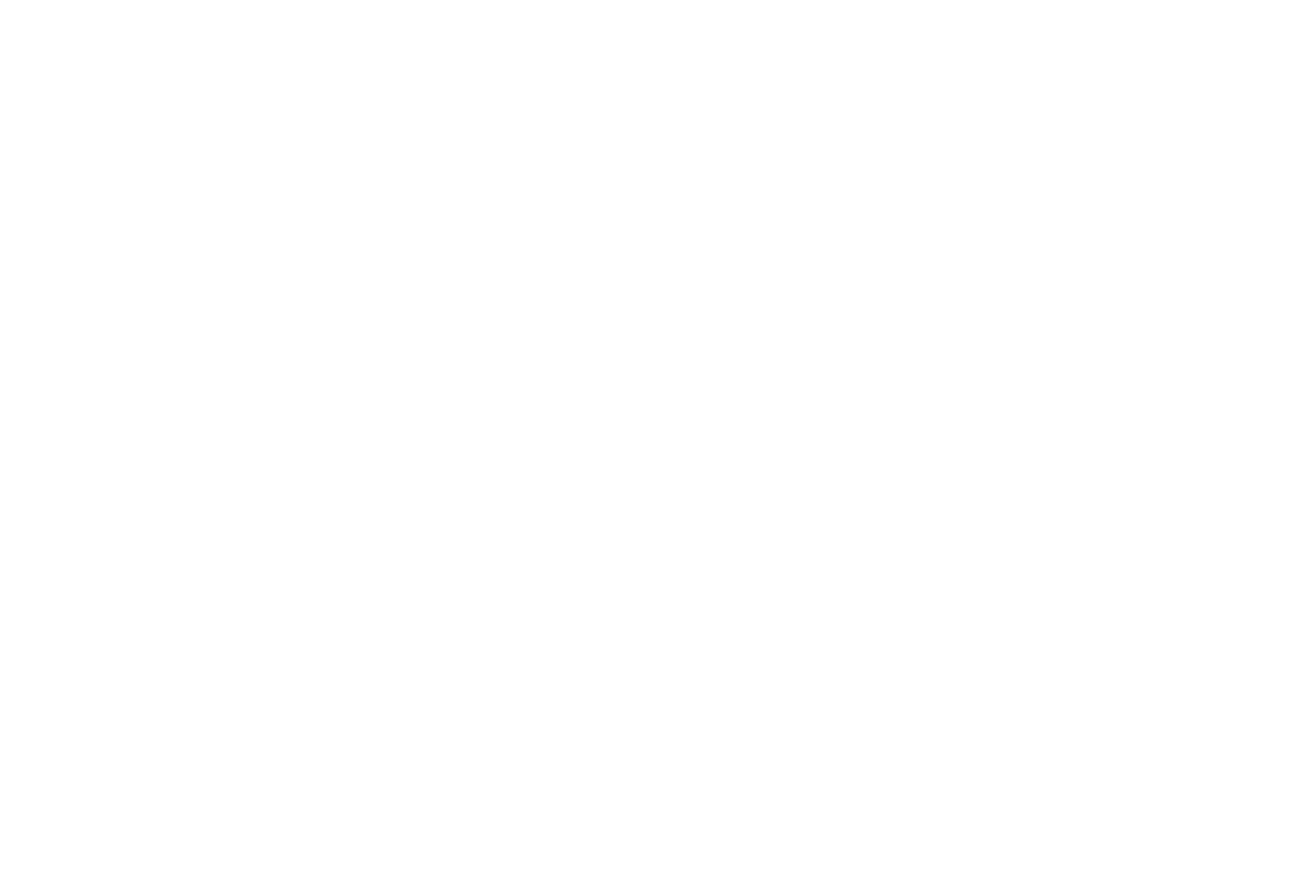
Frontiers in Genetics |